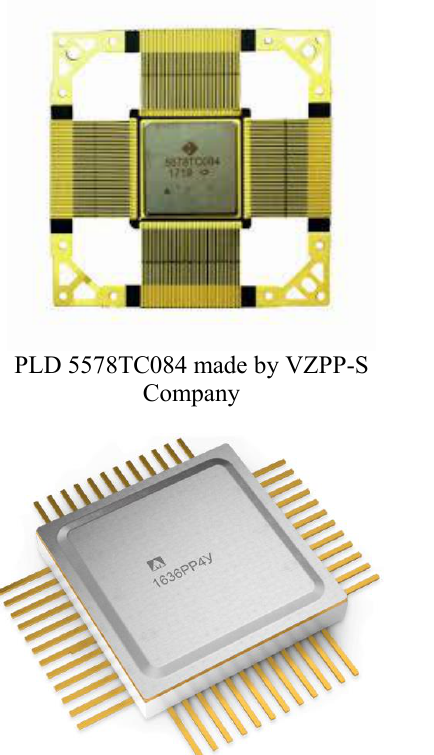
Fig. 3. Structure of the Ground Equipment. Ground equipment includes a beacon; optical infrared beacon; optical and radio markers placed on the runway; output signal generation module; a computing module and an information exchange module with a ground control point (GCP).